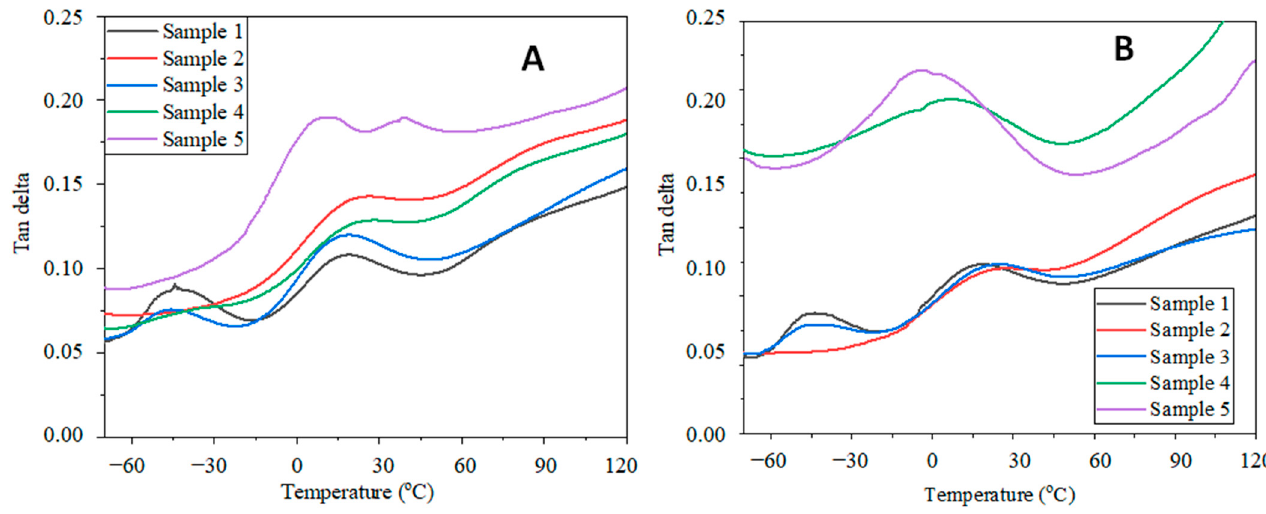
Figure 7. Tan delta results of the untreated ( A ) and EB compatibilized ( B ) PP/GTR/WF composites.